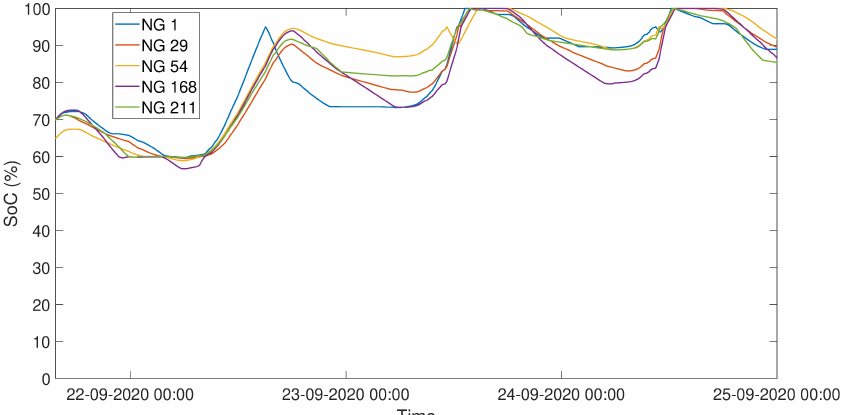
Figure 15. Evolution of the SoC of the NGs with a 1500 Wh communal load—communal load operation.